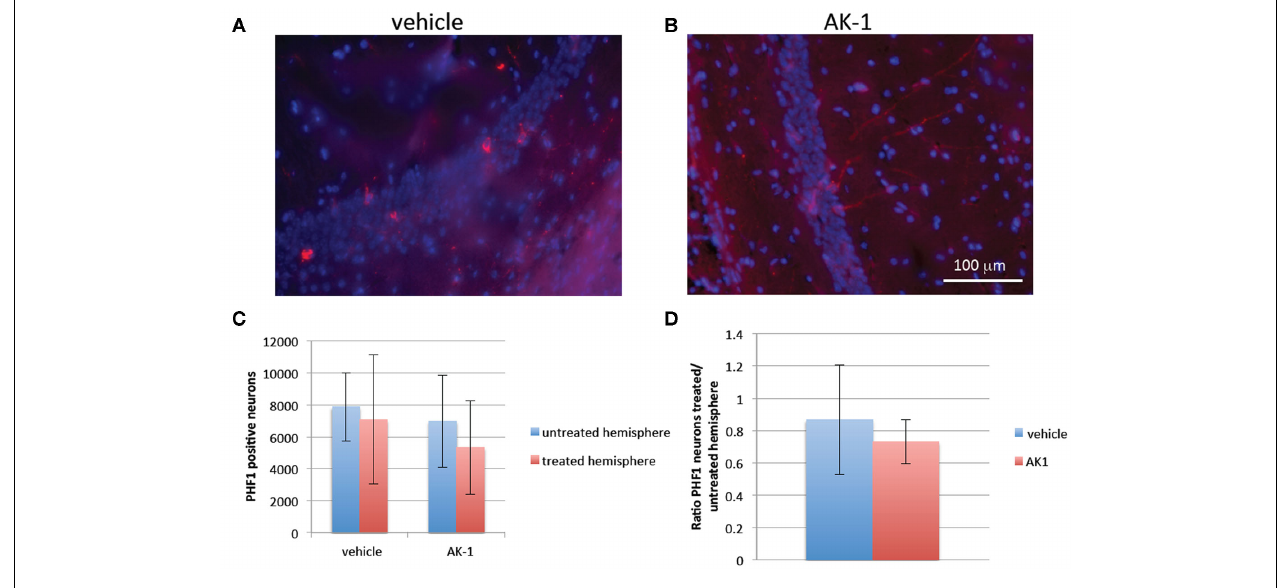
reveals no difference in the numbers of tangles in the treated and untreated hemispheres either when all animals are averaged (C) or when a ratio of treated/untreated hemisphere is calculated for each animal before averaging (D) .